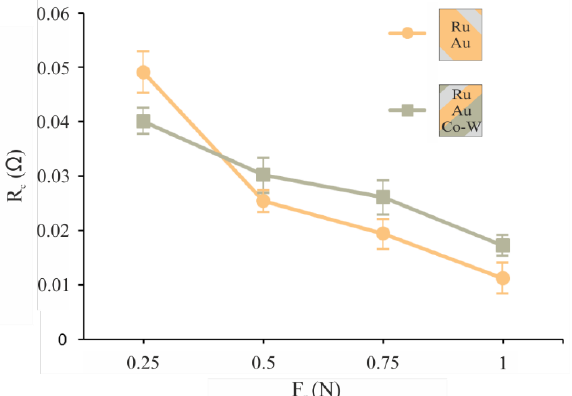
Figure 8. Transient resistance R c versus the pressing force F p for Au – Ru contact coatings with and without Co – W sublayer.